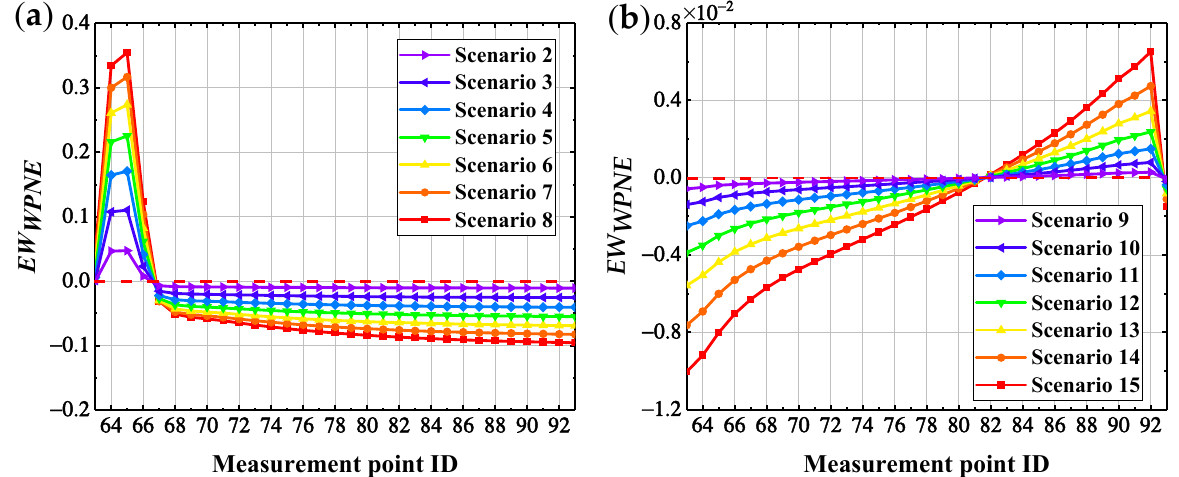
Figure 11. EW WPNE damage identification results: ( a ) damage I; ( b ) damage II.